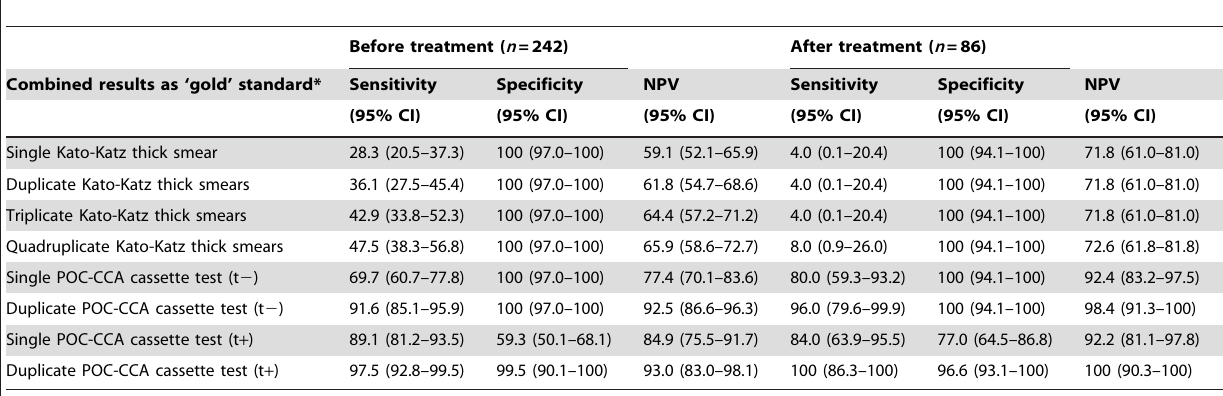
Table 4. Sensitivity, specificity, and negative predictive value (NPV) of different approaches for the diagnosis of S. mansoni .